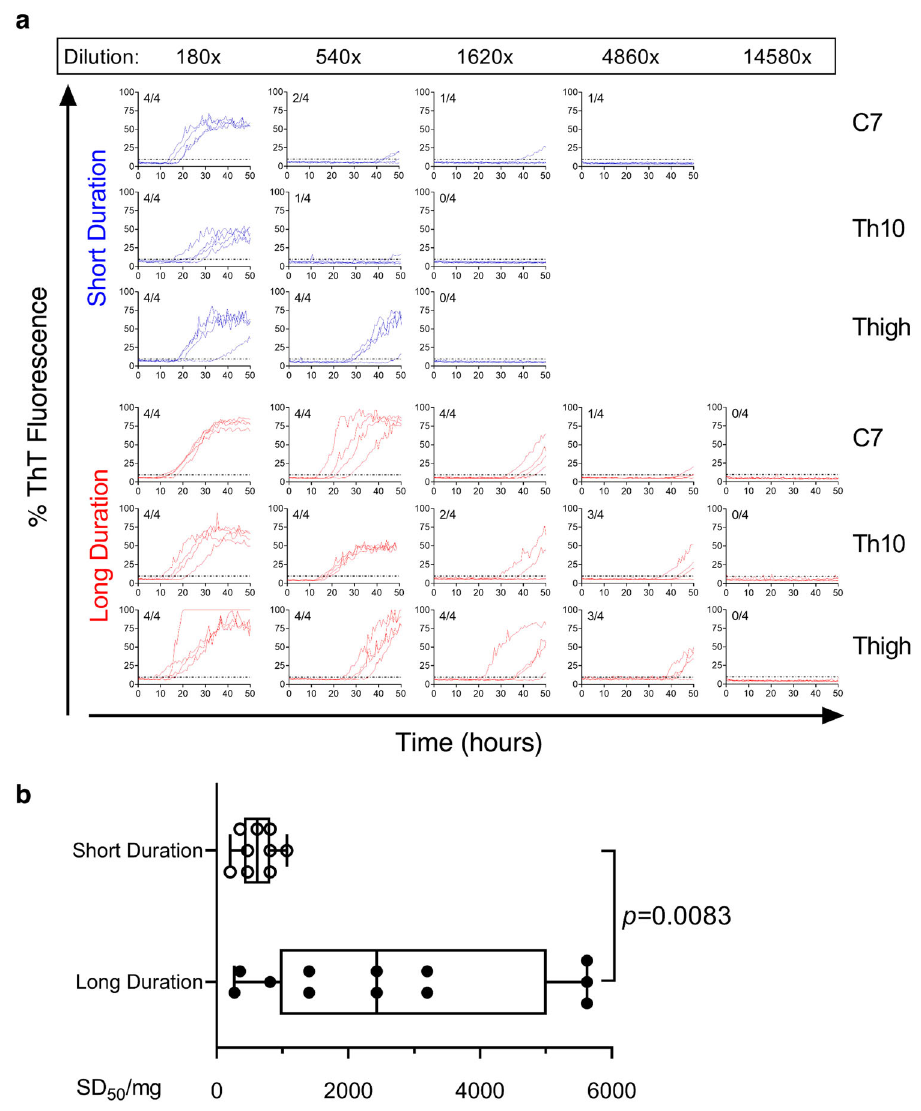
Fig. 5 Comparisons of α -syn seeding activity in skin biopsies of PD patients with different disease duration through endpoint dilution analyses. a RT-QuIC spectra of serially endpoint diluted skin biopsies collected at C7, Th10, and thigh from a PD patient with a short (7 years, blue curves) or long (28 years, red curves) disease duration. Dilution folds are indicated on the top. Shown are ThT fl uorescence traces from four replicate reactions at the designated dilutions. The fractions in the upper left corner of each graph indicate the positive/total replicate reactions. Dotted lines indicate a threshold of 9.6%. b Values of SD 50 /mg obtained from Spearman – Kärber endpoint analyses for skin biopsies from all anatomic sites of PD patents with short (5 – 7 years, n = 3) or long (15 – 28 years, n = 4) disease duration. A box plot demonstrates signi fi cantly higher SD 50 /mg in PD patients with long disease duration compared to those with short duration ( p = 0.0083, Mann – Whitney U test). The boxes represent the interquartile range with the median line and the whiskers extending to the most extreme data